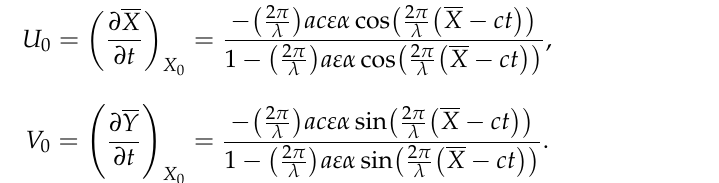
Figure 1. Schematic diagram of flow through the electroosmotic ciliated pump. Differentiating Equations (1) and (2) with respect to t to obtain the velocity components at channel wall